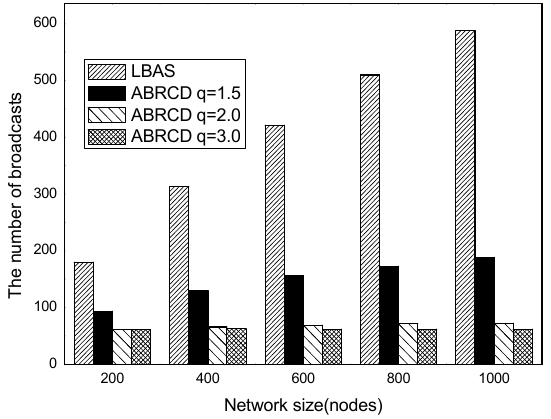
Figure 33. The impact of network size with fixed | T | = 40 on the number of broadcasts.